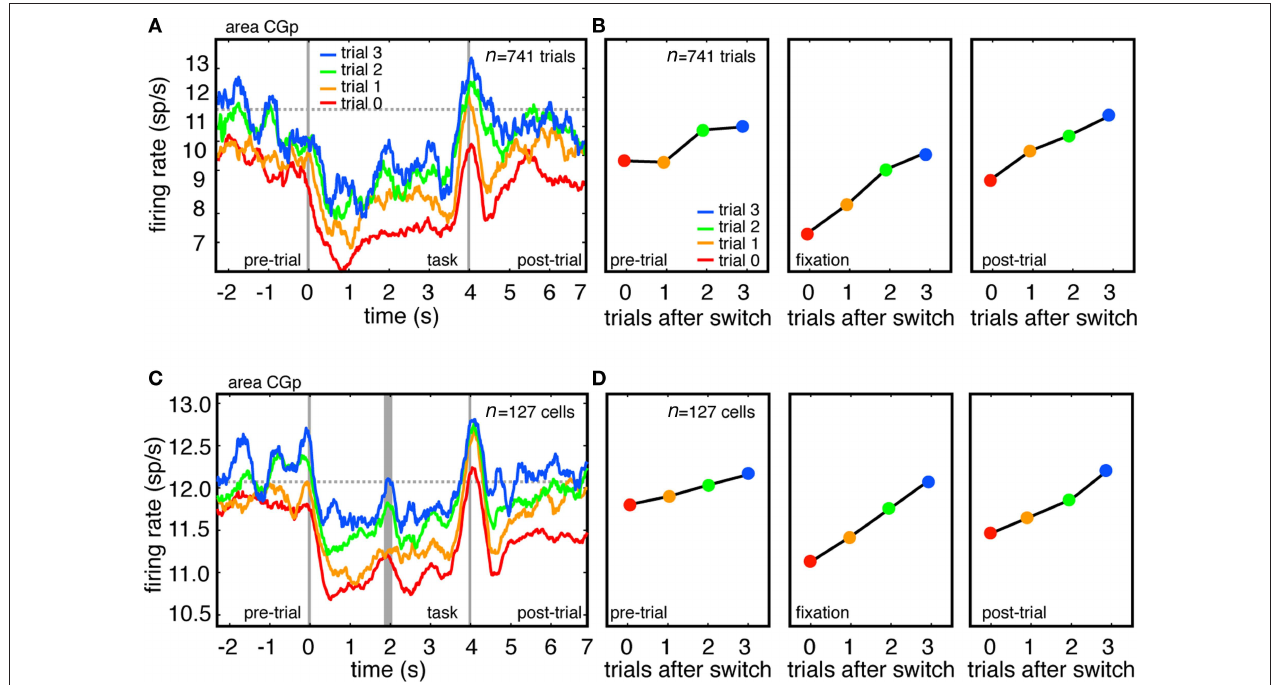
Figure 2 | Firing rates of Cgp neurons track task switches. (A) Responses of example CGp neuron immediately following switch (trial 0), and on first,